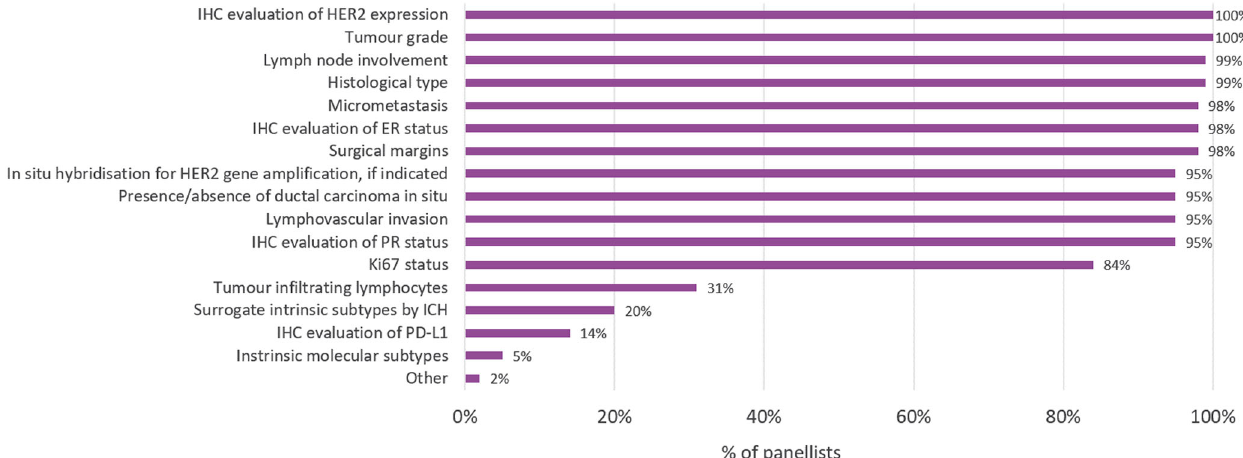
Fig. 2 Information included in the pathology or surgical sample report of patients with breast cancer. Percentage of panellists stating the parameters that are included in the report. ER oestrogen receptor, IHC immunohistochemistry, PR progesterone